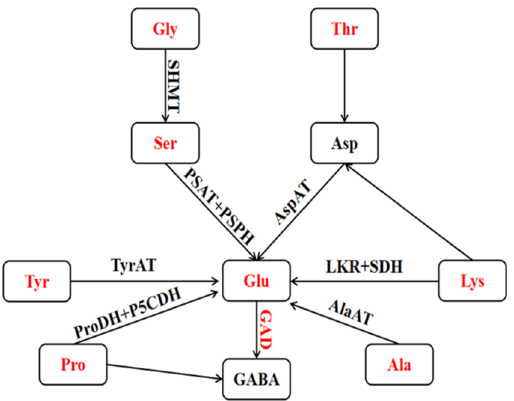
Figure 8. Mechanism of GABA-shunt pathway for GABA accumulation in highland barley under HRH treatment. The red marks represent the parameters, which were significantly and positively correlated with GABA accumulation under HRH treatment. GAD, glutamate decarboxylase; AlaAT, Ala aminotransferase; TyrAT, Tyr aminotransferase; AspAT, Asp aminotransferase; LKR, Lys-ketoglutarate reductase; SDH, saccharopine dehydrogenase; PrpDH, Pro dehydrogenase; P5CDH, pyrroline-5-carboxylate dehydrogenase; SHMT, serine hydroxymethyltransferase; PSAT, phosphoserine transaminase; PSPH, phosphoserine phosphatase.